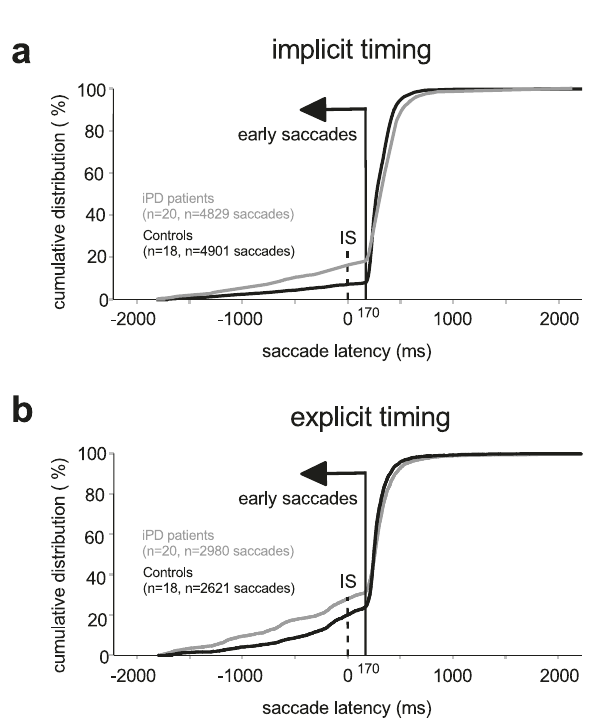
Fig. 2 Cumulative saccadic latency histograms. Implicit ( a ) and explicit ( b ) timing conditions. T ON , target (imperative stimulus) onset. Early saccades occur before the in fl ection point in the distributions (latency < 170 ms, vertical continuous line). Time zero on the X-axis represents the onset of the